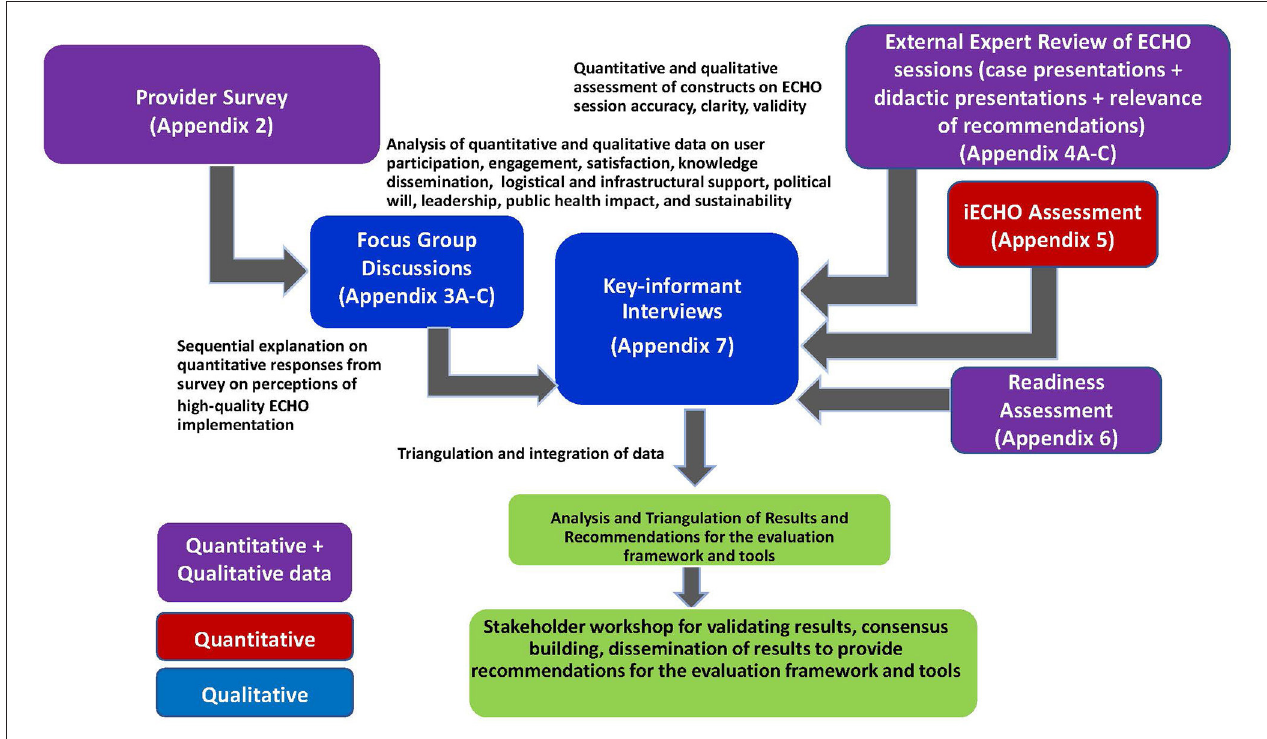
FIGURE 3 | Triangulation of the key concepts from qualitative and quantitative data collection